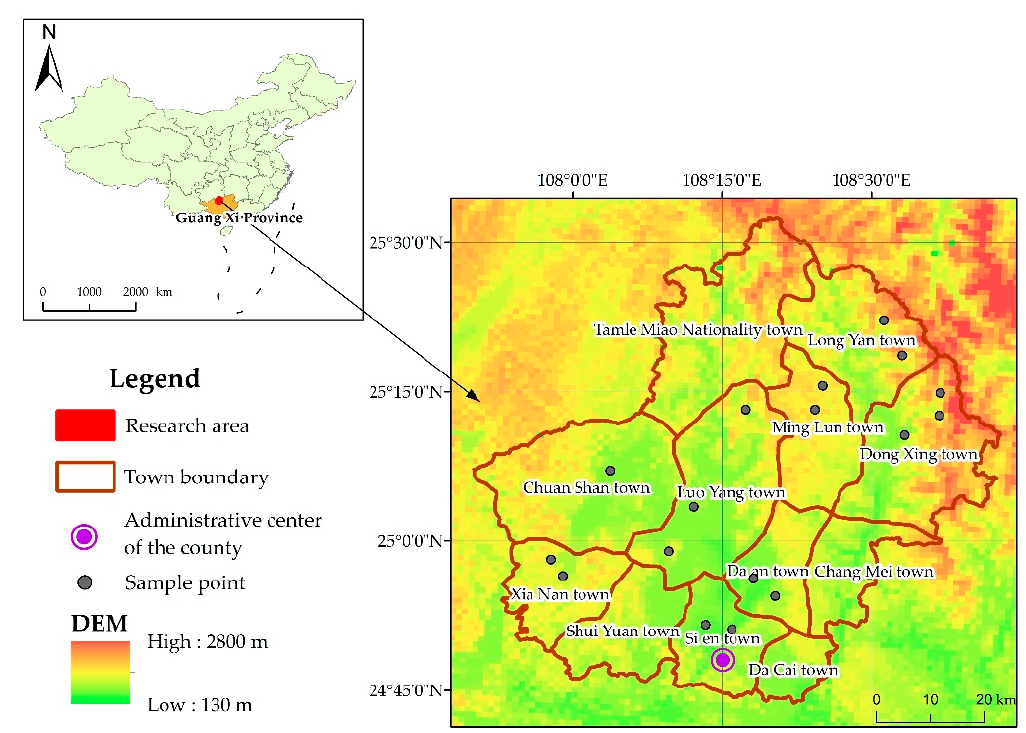
Figure 1. Map of Huanjiang County and its townships.